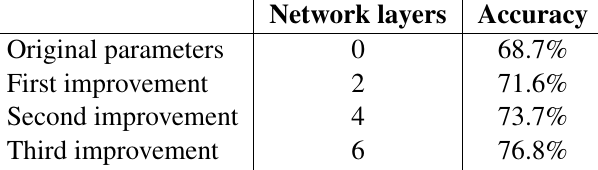
Fig. 9 Results of some word vectors. Table 1 Experimental results of network